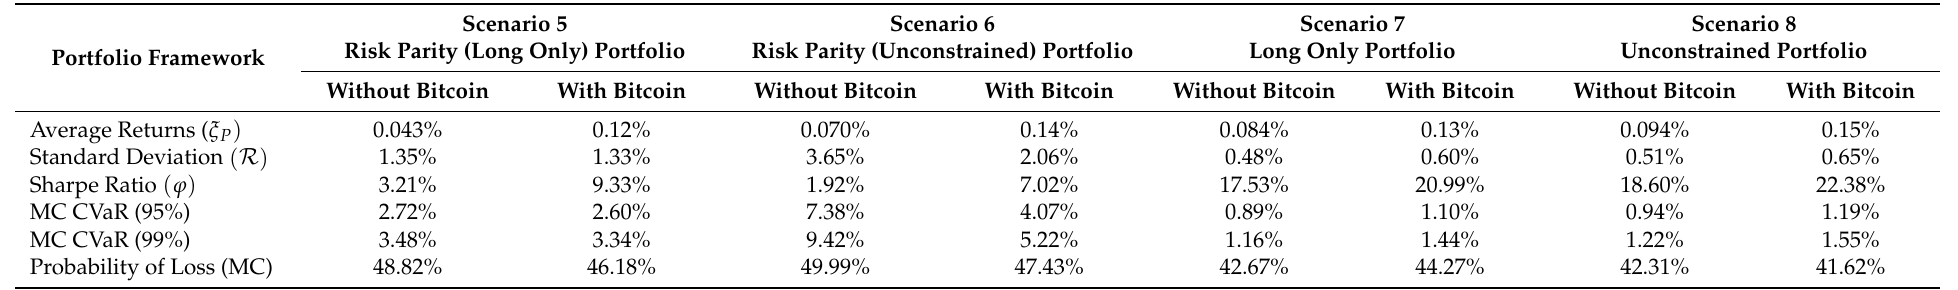
Table 7. Monte Carlo Simulation Results (Scenarios 5 to